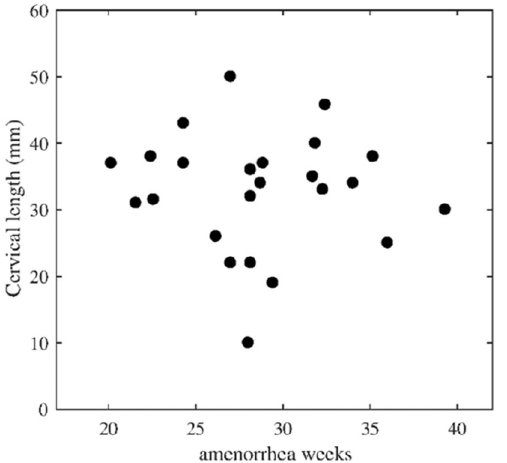
Figure 4. Evolution curve of the cervical length measured by transvaginal ultrasound (standard procedure) according to the gestational age. No correlation is observed between cervical length and gestational age.